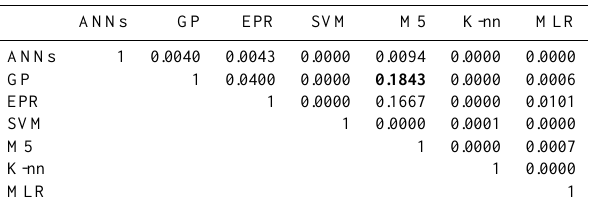
Table 13. The p -values of the two samples K-S test on the model residuals (till moisture).